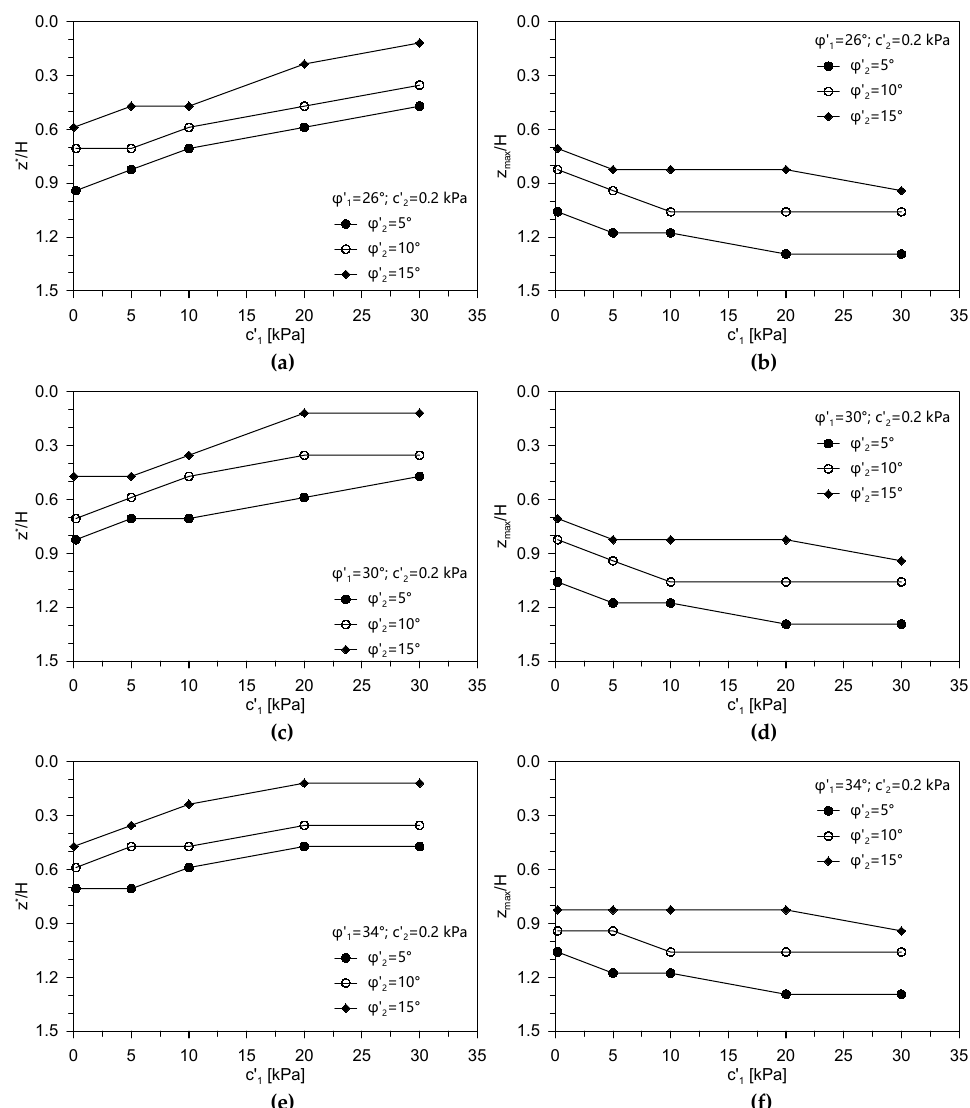
Figure 13. Evolution of the ratio between the critical depth z*and the height of the embankment H and of the ratio between the maximum depth z max and the height of the embankment H as a function of the intercept cohesion of the foundation soil c 1 ’ and of the shear strength angle of the foundation soil. ( a , b ) φ 1 ′ = 26°, ( c , d ) φ 1 ′ = 30°, ( e , f ) φ 1 ′ = 34°.